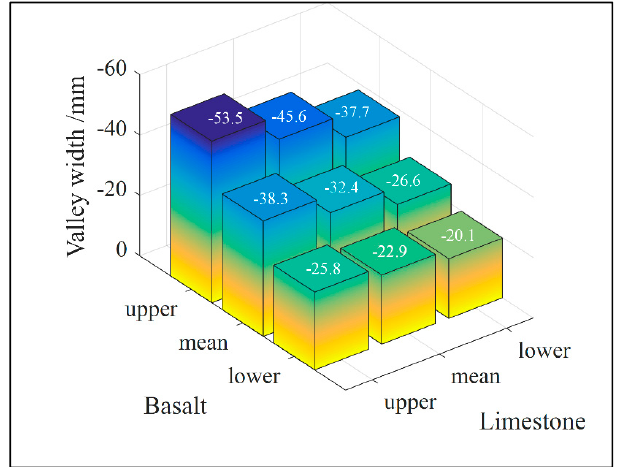
Figure 21. The sensitivity of valley deformation considering different conductivities of the weathered rock strata. (1 January 2013–1 January 2015).